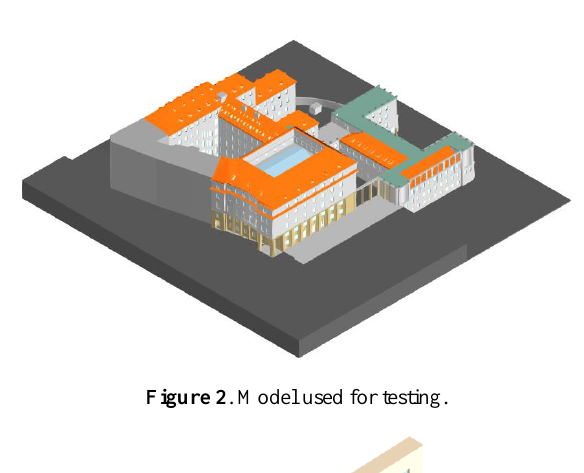
Figure 2 . Model used for testing.